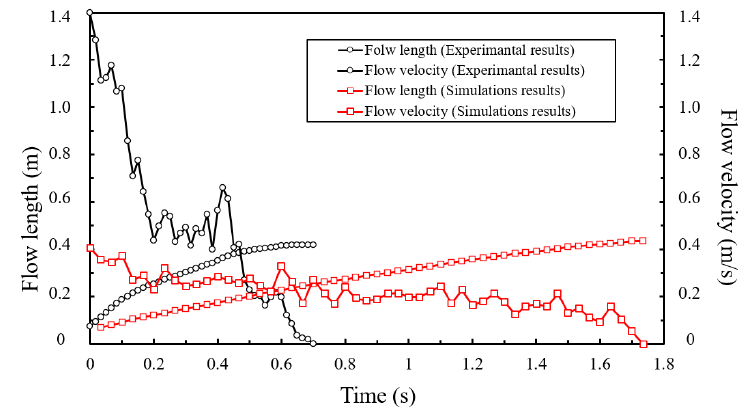
Figure 10. Calculation of flow velocity and flow length in experimental as well as simulation results (Cu–Sn).